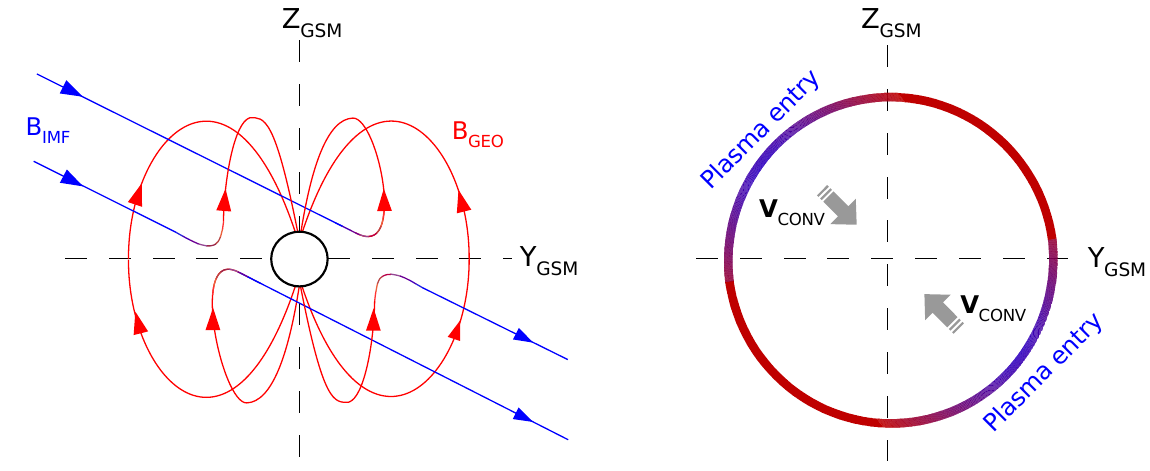
Fig. 6. Schematic illustration of the dayside reconnection (left) and corresponding plasma entry and convection towards the tail plasma sheet (right) for a southward IMF with a strong positive By component. The view is from the Sun and looking tailward. The geomagnetic field (red lines) reconnects to the IMF (blue lines) and are dragged tailward along the flanks. For this IMF configuration, the plasma entry takes place along the the blue marked regions in the northern dawn and southern dusk flank regions.